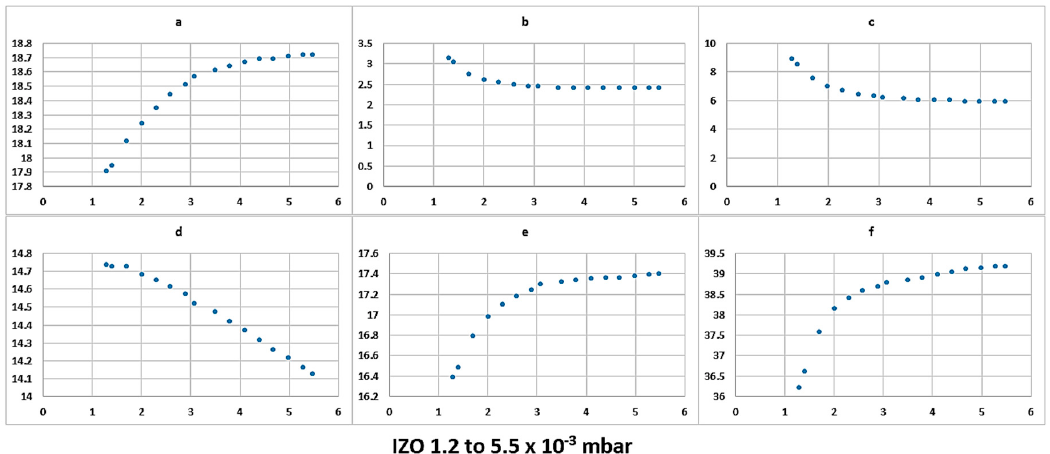
Figure 16. These data demonstrate the ratio (to the total spectral cover from 300 to 800 nm) of the area under the peak in each of the segments in response to varying the chamber pressure. Sections ( a , e , f ) demonstrate and increase while ( b – d ) demonstrate a decrease of intensity when increasing the chamber pressure to 5.5 × 10 − 3 mbar.